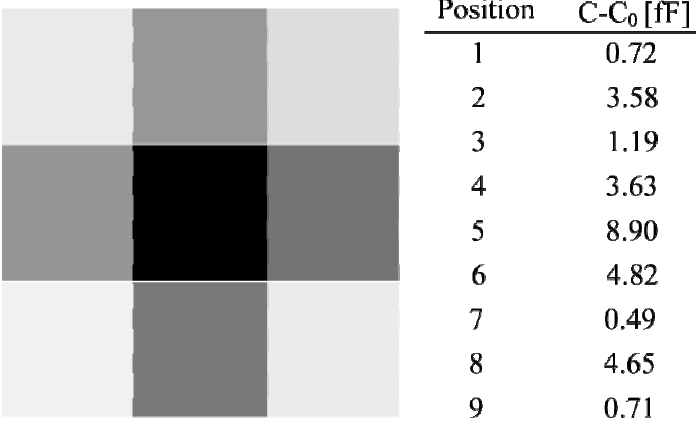
Figure 10. Capacitance variation of the 9 cells when a distributed pressure was applied with a sphere 5.5 mm in